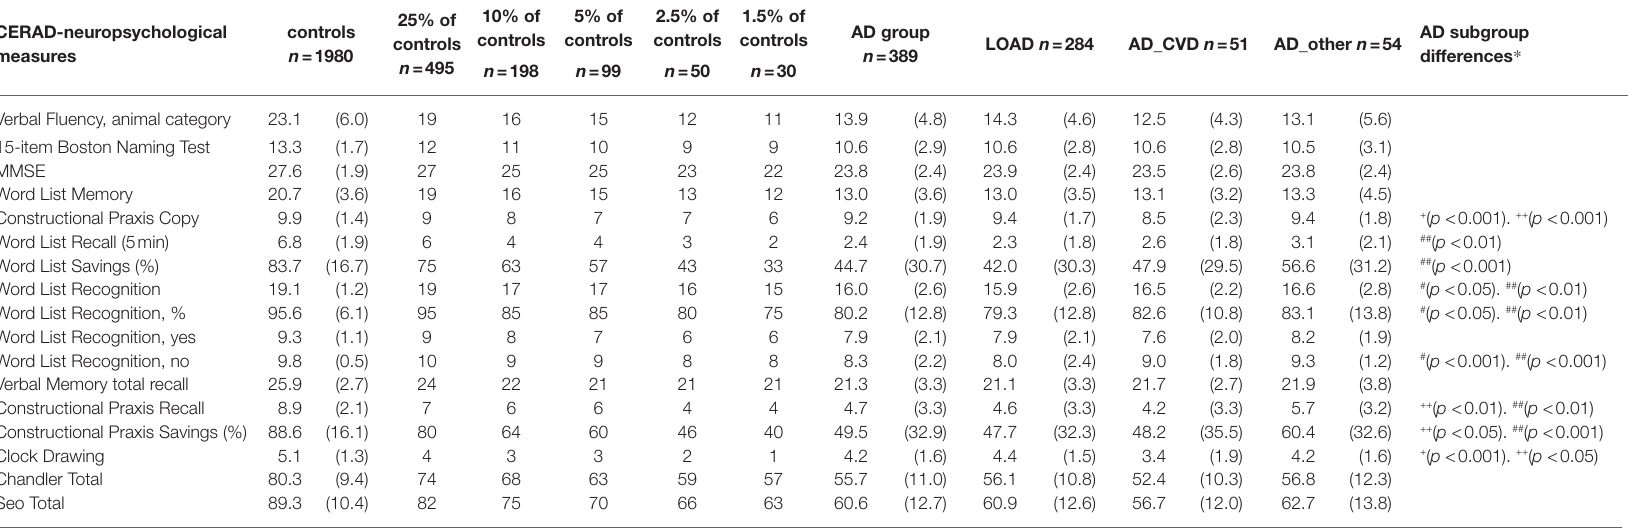
TABLE 2 | Cognitive performance [mean, (SD)] for measures of the CERAD neuropsychological battery in the controls, AD group total, and AD subgroups.